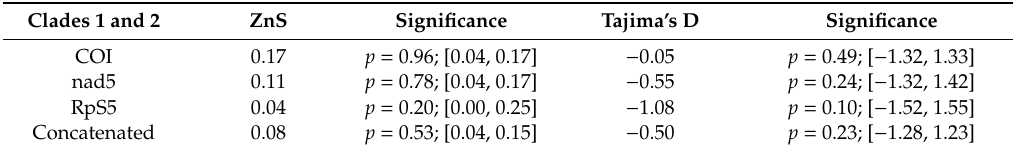
Table 2. Inferences on Tunisian population variability based on Tajima’s D, the site frequency spectrum (SFS) of mutations; and ZnS, the statistical association among those (linkage disequilibrium). Clades 1 and